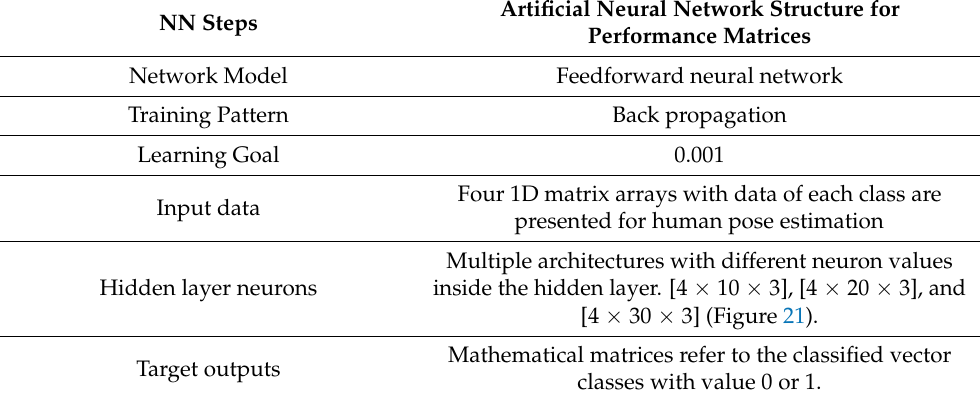
Mathematical matrices refer to the classified vector classes with value 0 or